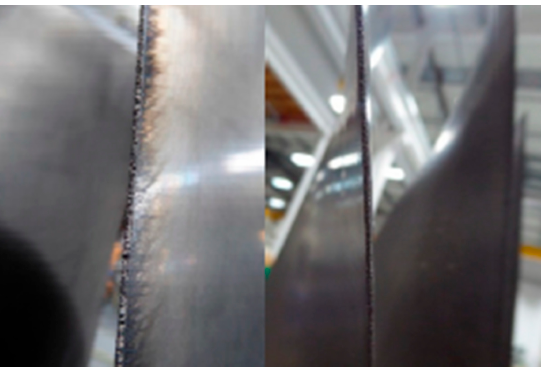
Figure 3 . Example of erosion phenomenon on the leading edge of fan blades